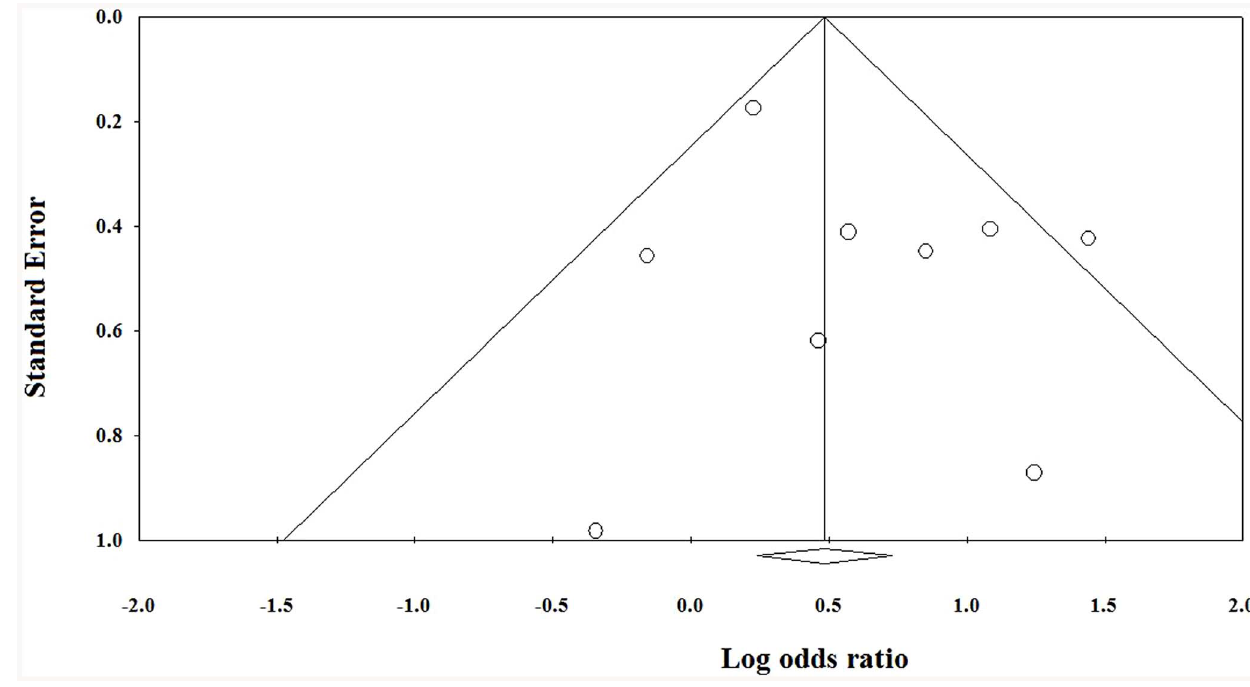
Figure 3. Funnel plot of the standard error by mean difference for 5-year survival rate.